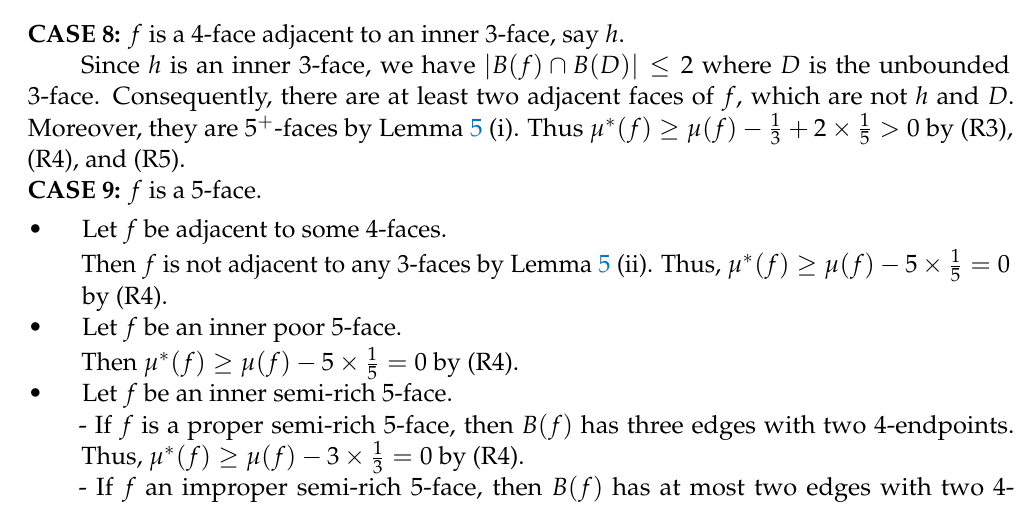
Figure 4. The configuration in CASE